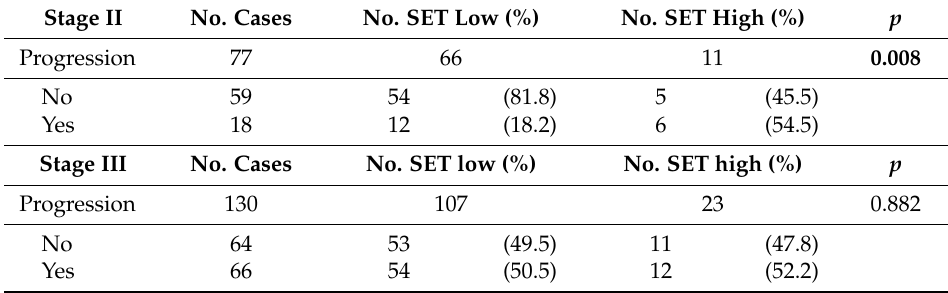
Table 2. Association between SET and progression (local or distant) in 207 stages II-III CRC